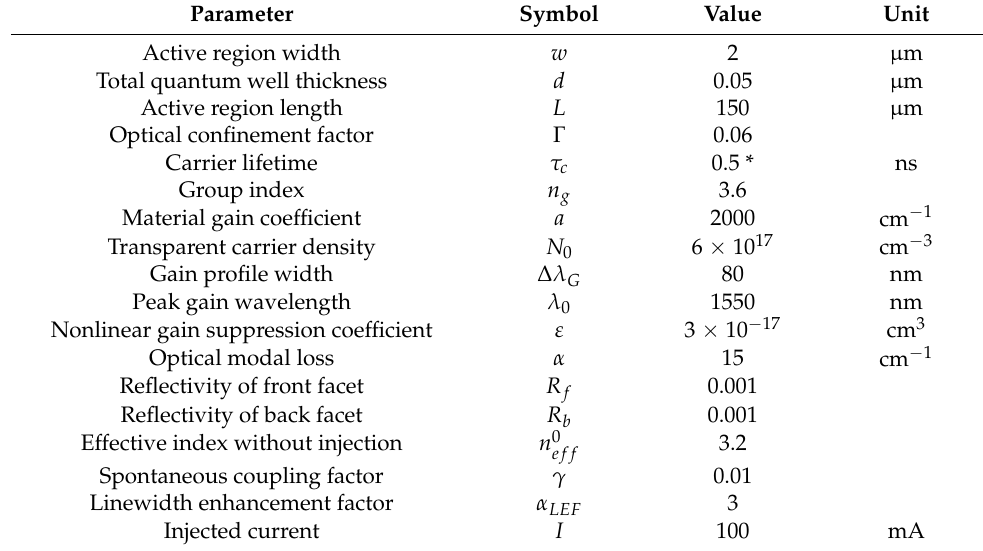
Table 2. Parameters of the